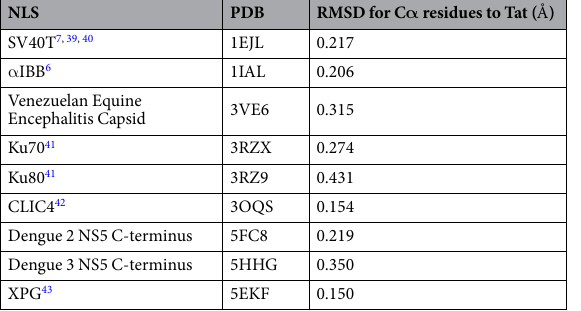
Table 4. RMSD differences of PDB deposited cNLSs binding to the major site of importin- α